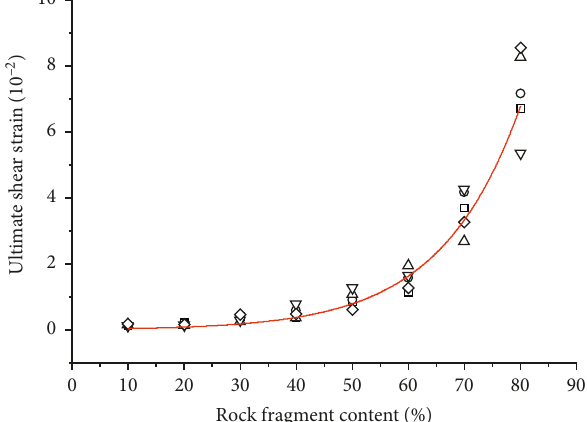
Figure 10: Relationship between ultimate shear strain and rock block